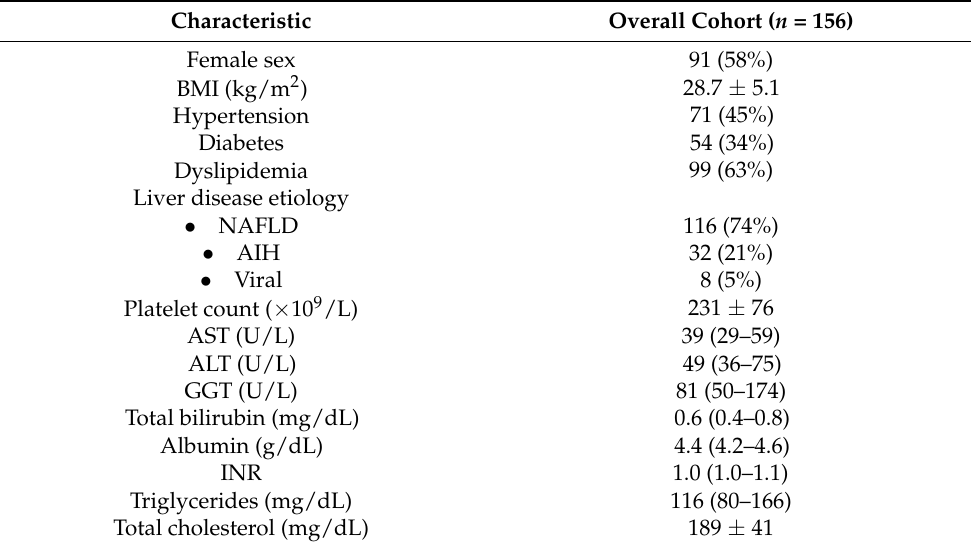
Table 1. Characteristics of the included population.